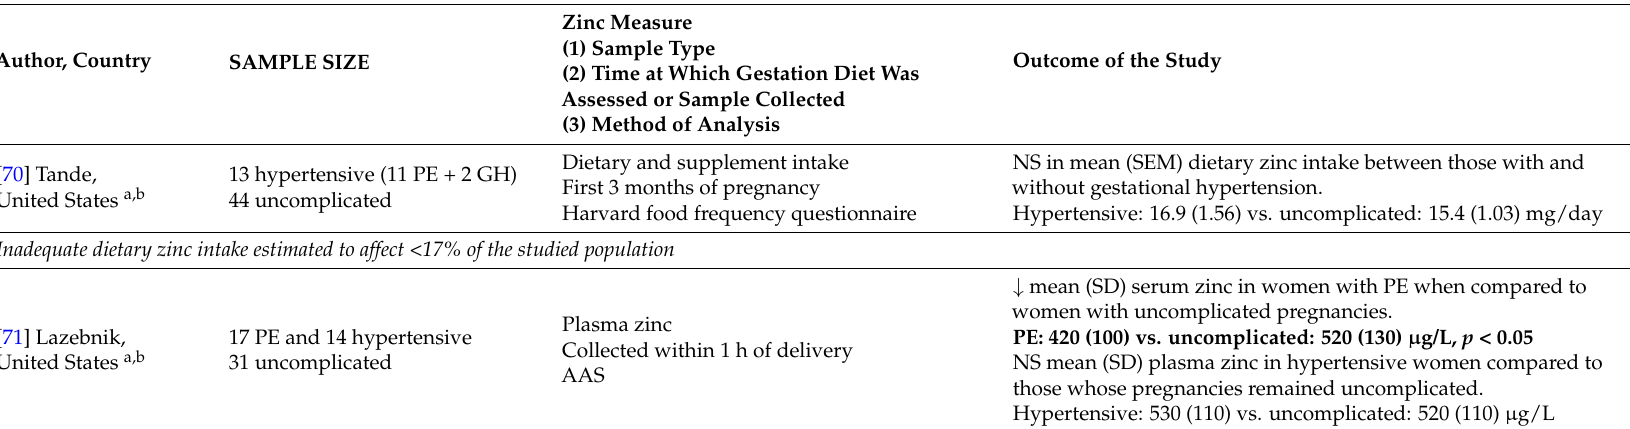
Table 2. Included studies assessing maternal zinc status and hypertensive disorders of